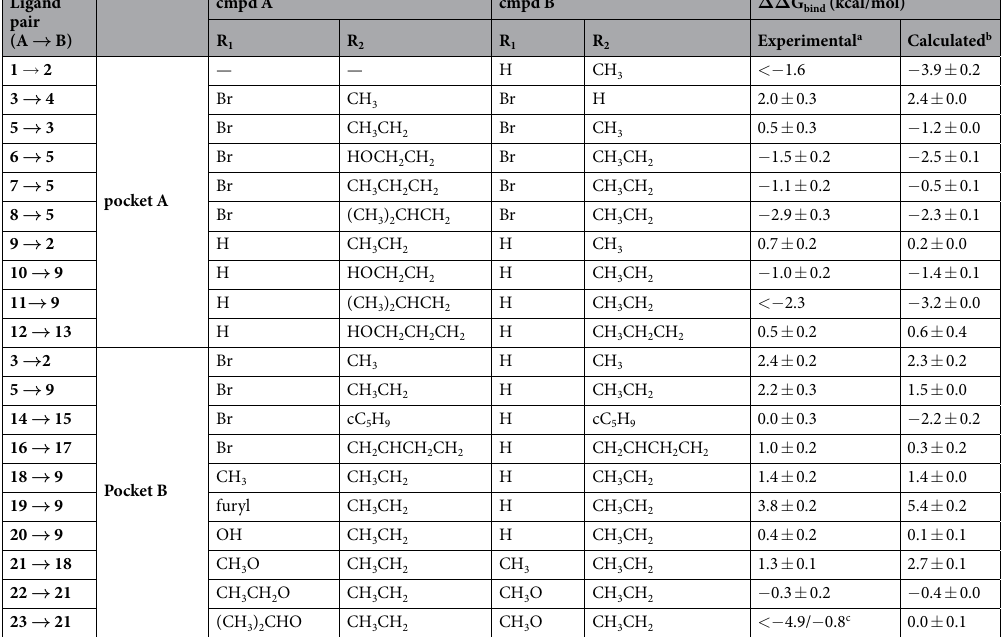
Table 1. Calculated and experimental relative binding free energies for 20 compound pairs based on adenine. 2D structures of the compounds are shown in Fig. 1C. a Uncertainties are calculated as the standard error of the mean based on the maximal and minimal affinities values obtained from the 95% confidence intervals of the experimentally determined